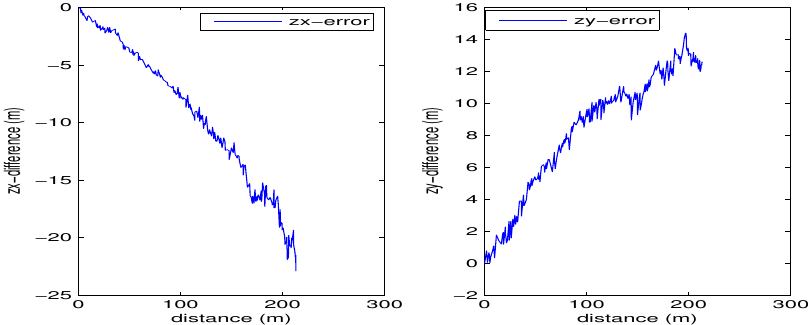
Figure 3. The measurement errors in the process of Autonomous Underwater Vehicle (AUV) docking with fixed docking station